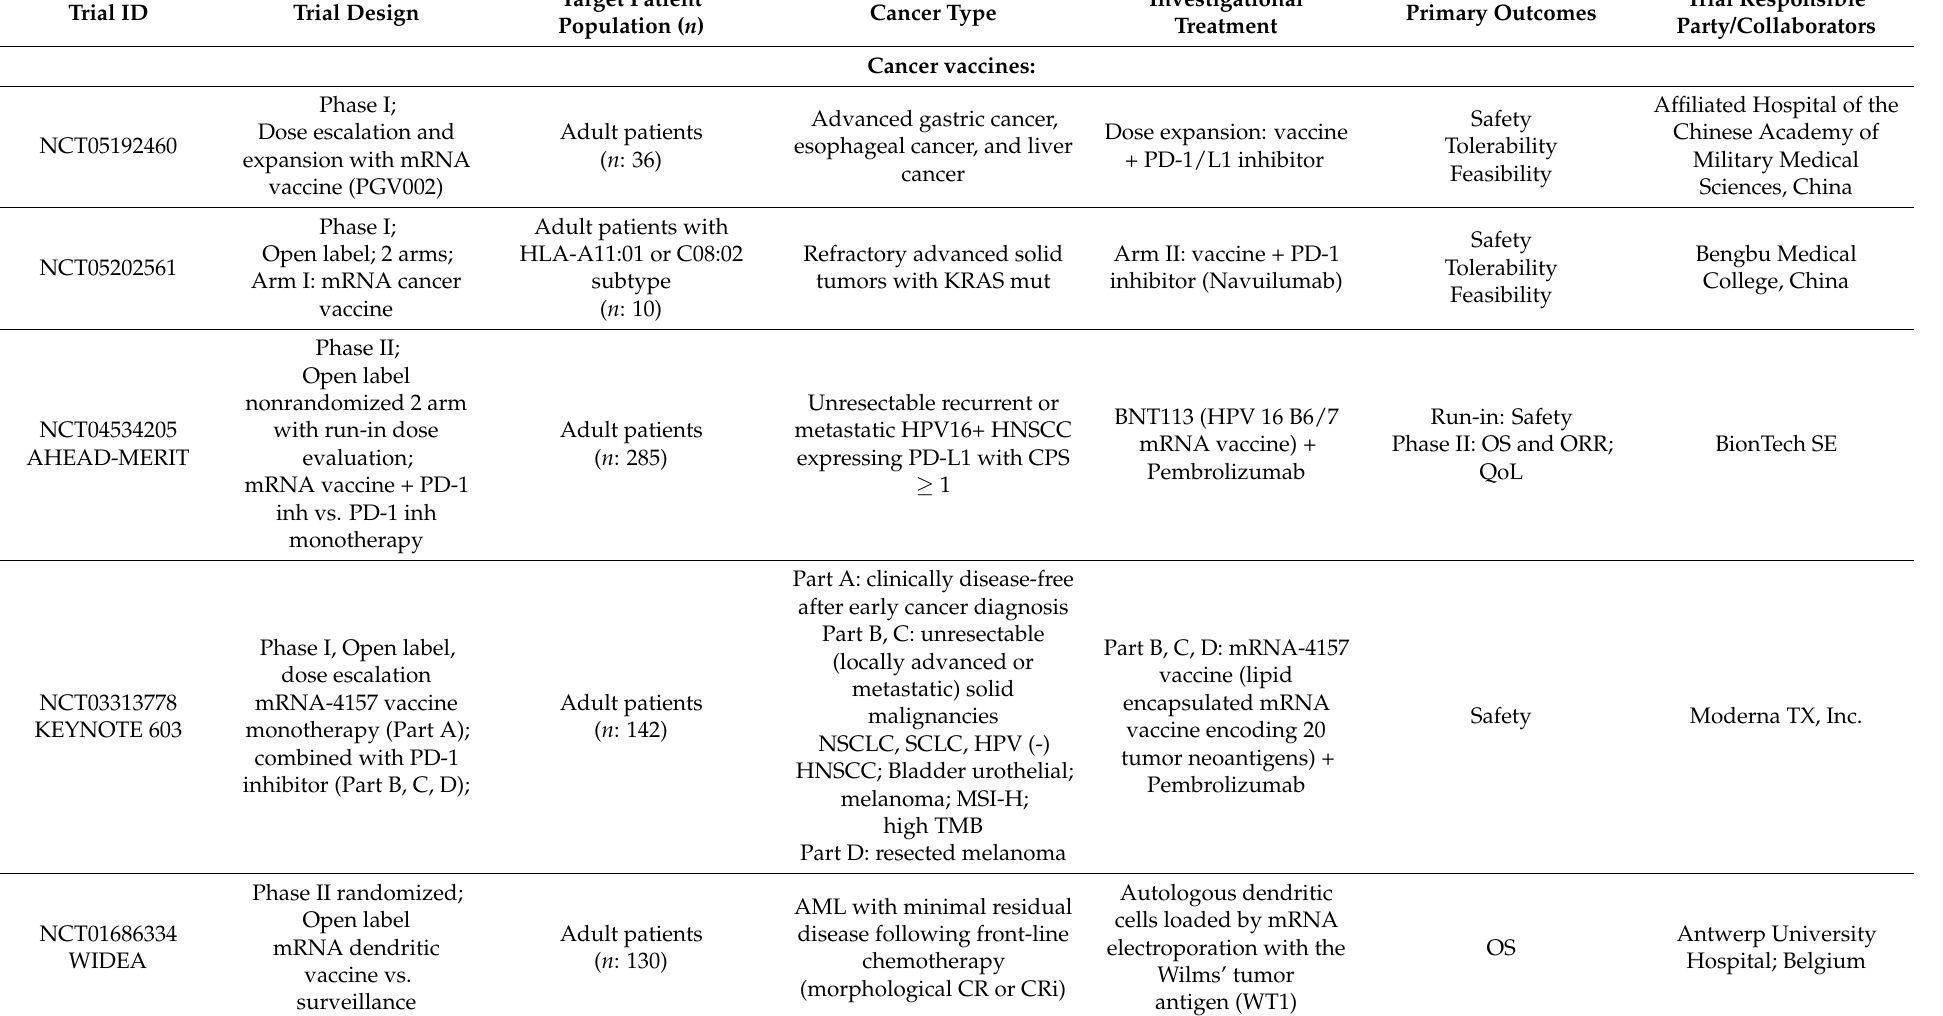
Table 1. Ongoing trials with mRNA-based